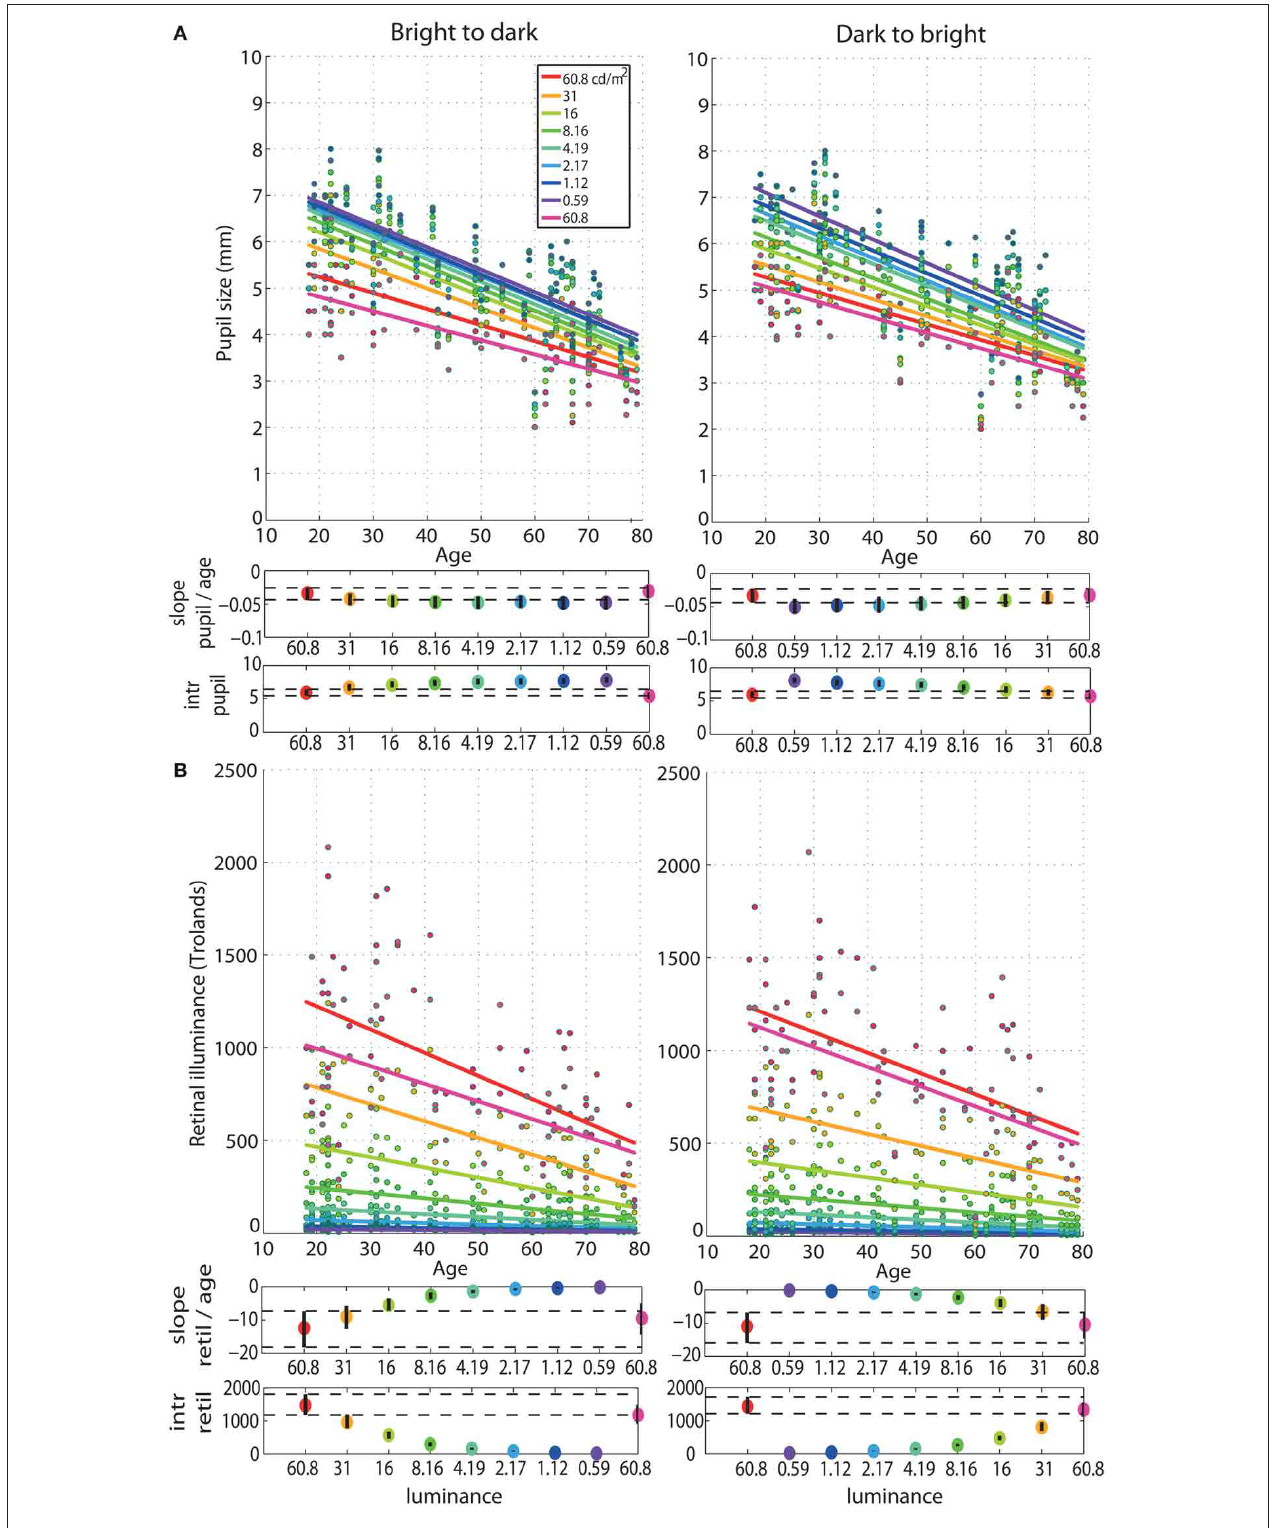
FIGURE 6 | Regressions of pupil size and retinal illuminance against age. (A) Regression fits between pupil size and age and (B) between retinal illuminance (retil) and age, for all luminance levels. See Figure 4 caption for details.